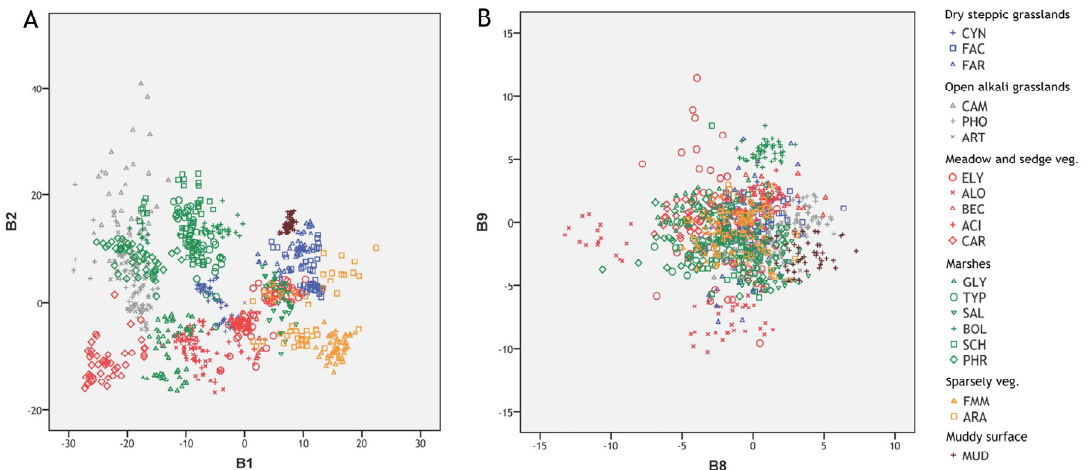
( B ) B8 and B9. Identical vegetation groups are represented by the same color (cyan—dry steppic grasslands; gray—open alkali grasslands; red—meadow and sedge vegetation; green—marshes; orange—sparsely vegetated areas; brown—muddy surface).